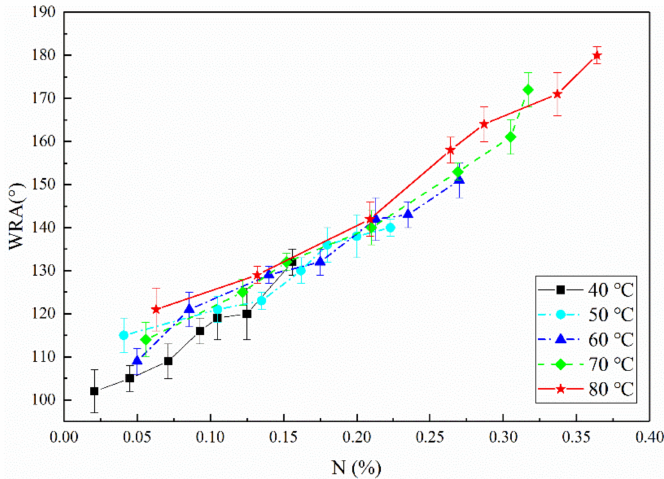
Figure 2. Relationship between nitrogen content and